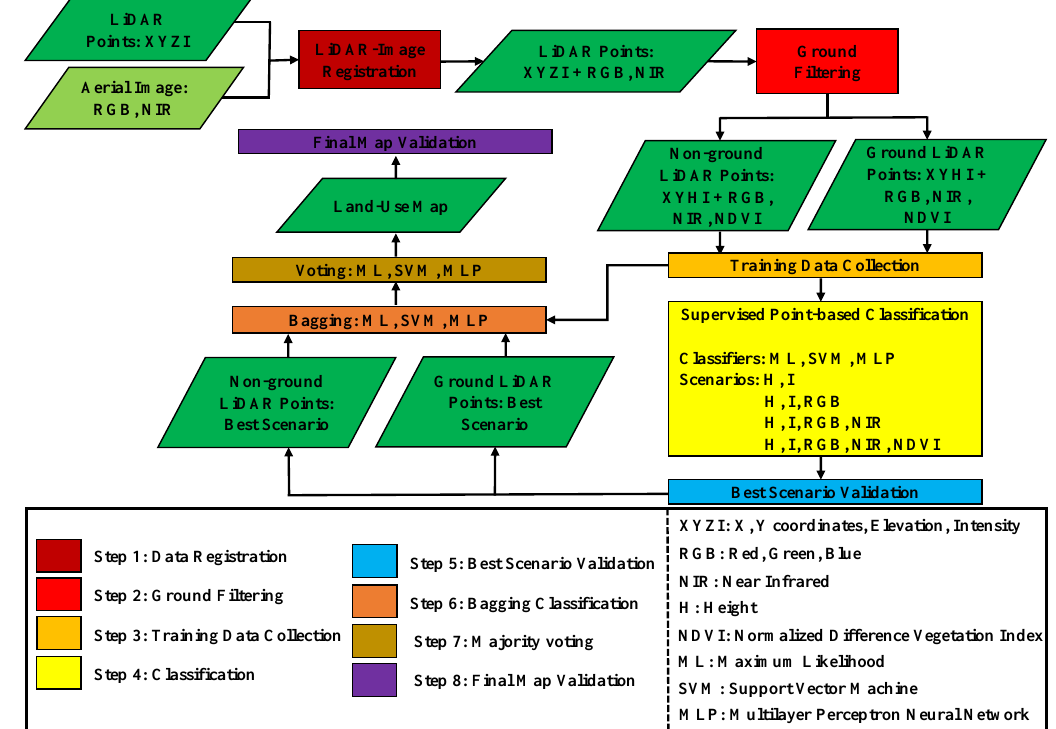
Figure 2. Conceptual overview of the proposed